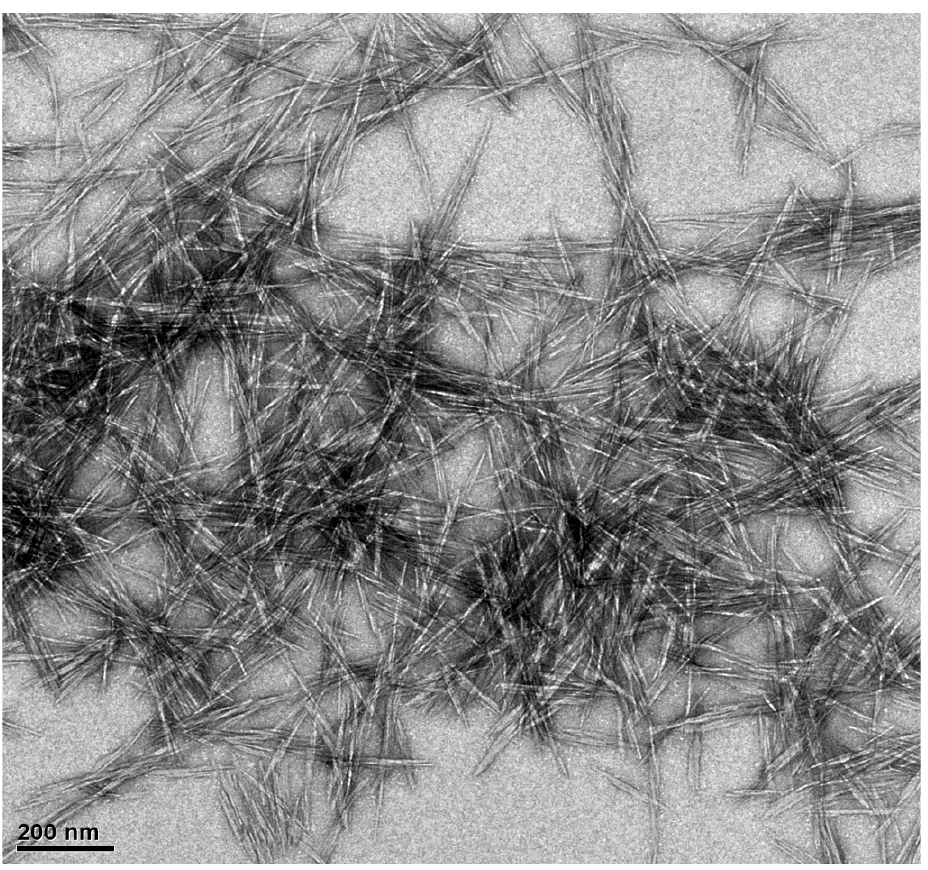
Figure 3. TEM of CNCs from durian rind.